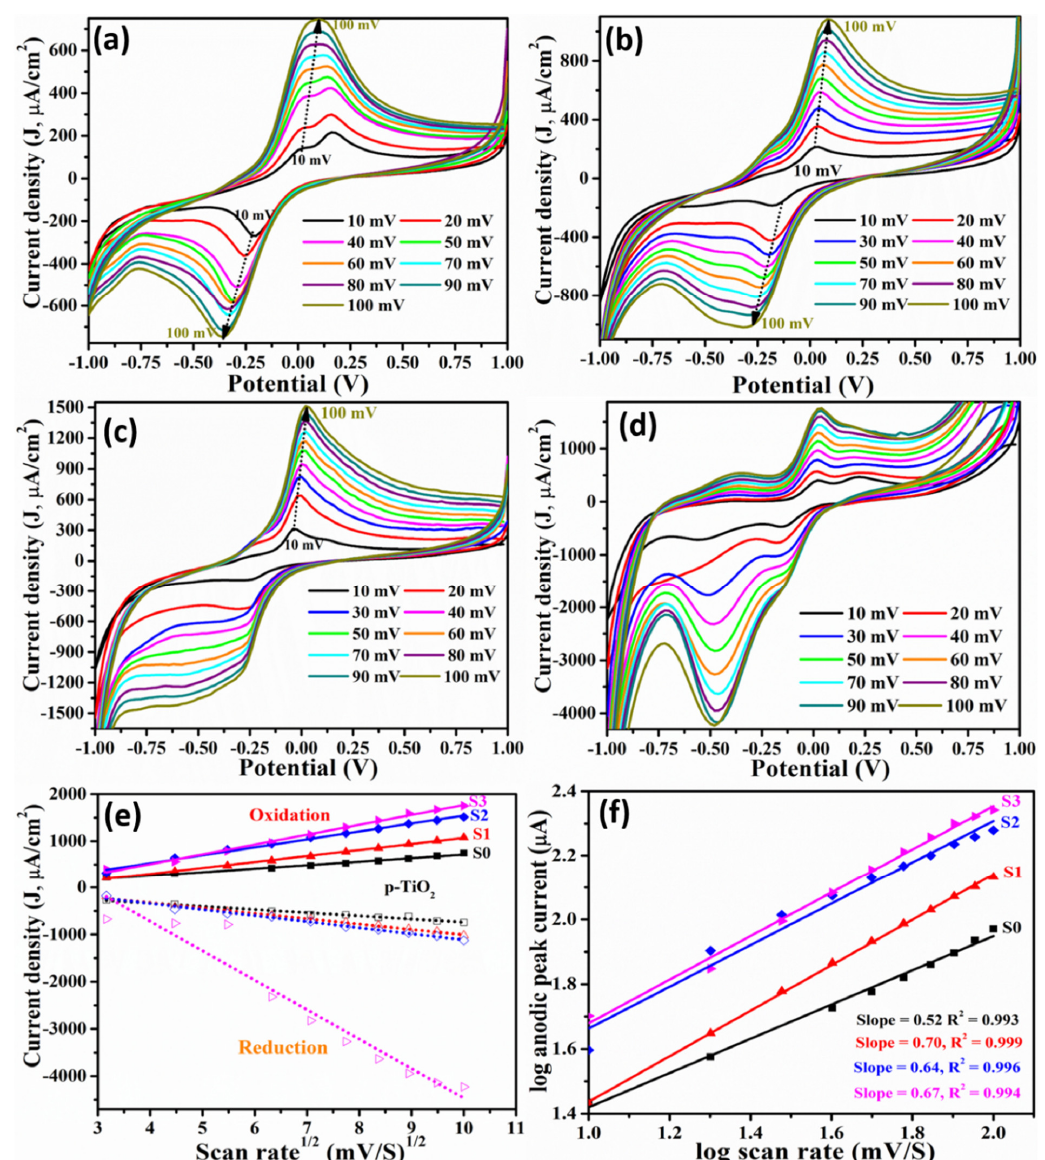
Figure 7. Effect of scan rate on the CV characteristics obtained at 7 nM of Mb for electrode made of ( a ) S0: pristine TiO 2 ( b ) S1; TiO 2 with 13 × 10 17 Mn atoms/cm 3 ( c ) S2: TiO 2 with 20 × 10 17 Mn atoms/cm 3 ( d ) S3: TiO 2 with 32 × 10 17 Mn atoms/cm 3 ( e ) peak current (both oxidation and reduction) versus square root of scan rate, and ( f ) log of peak current (oxidation) versus log of scan rate show linear response.